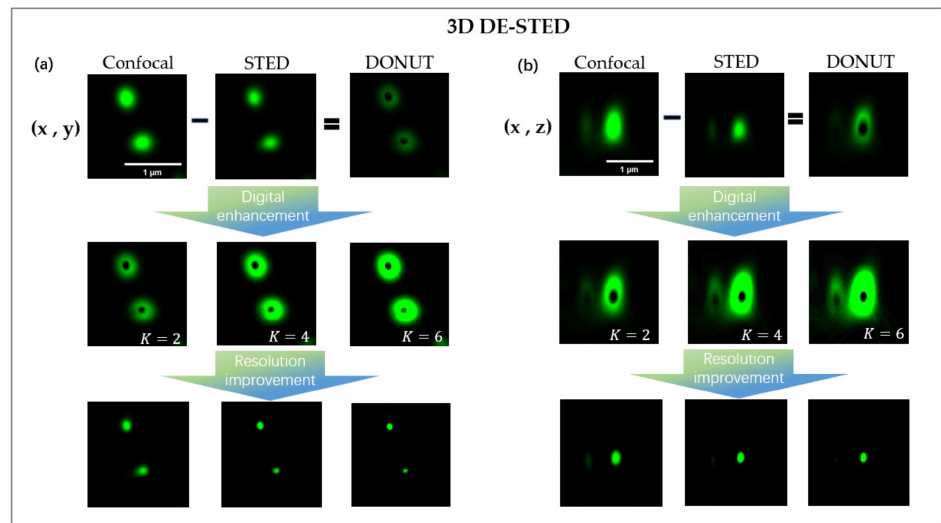
Figure 2. Schematic principles of 3D DE-STED. ( a ) Schematic of the distribution of PSF in (x, y). ( b ) Schematic of the distribution of PSF in (x, z). The center zero-intensity area of the 3D hollow exhaustion spot decreases with increasing K. The principle of 3D DE-STED for achieving resolution improvement in the sample of fluorescent beads with increasing K and without increasing the depletion laser